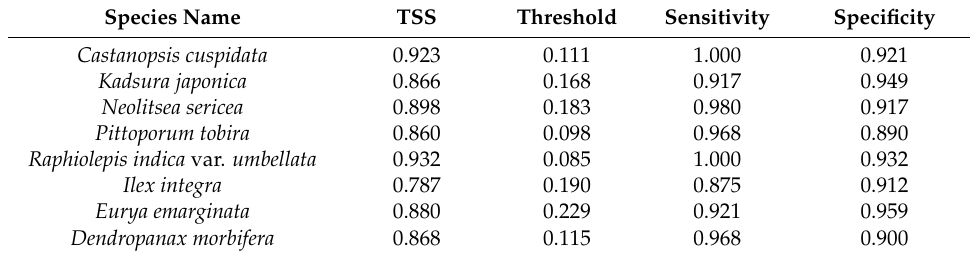
Table 2. Evaluation statistics of ensemble projections. TSSs, Sensitivities, and Specificities were calculated from the ensemble projection of each species using the full dataset. Sensitivities and specificities were calculated based on the threshold of suitability at which the TSS value was the maximum.